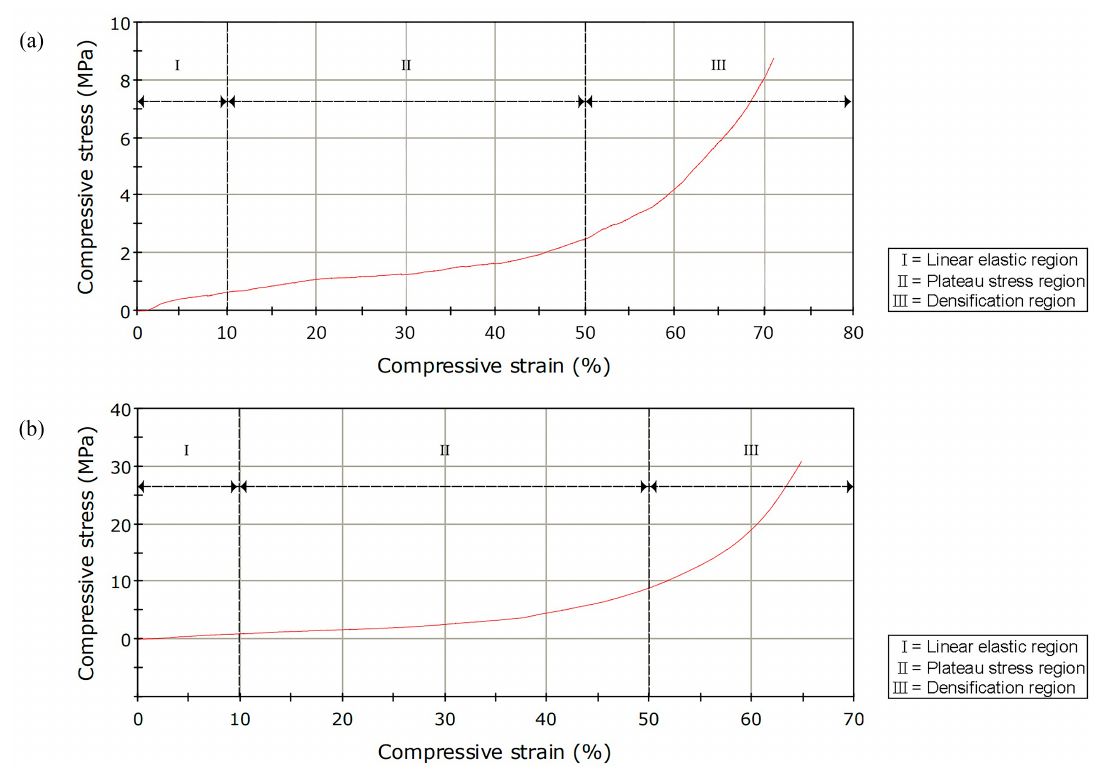
Figure 9. Compressive stress-strain curve of porous Copper; ( a ) as-received, ( b ) 680 °C, 15 min.